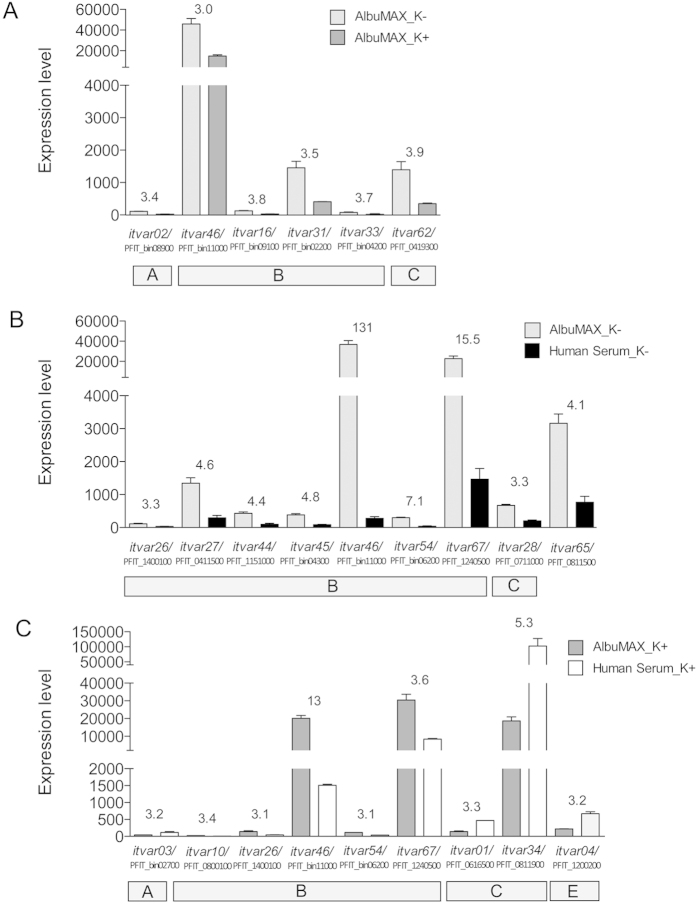
Expression of var genes differentially expressed by isolate FCR3 under different culture conditions.(A) Differential expression of var genes by FCR3 parasites in knobby (K+) and knobless (K−) IEs cultivated in the presence of AlbuMAX. (B) Differential expression of var genes by FCR3 parasites in knobless IEs cultivated in the presence of AlbuMAX or human serum. (C) Differential expression of var genes by FCR3 parasites in knobby IEs cultivated in the presence of AlbuMAX or human serum. Numbers above columns indicate x-fold expression with padj of ≤0.05.